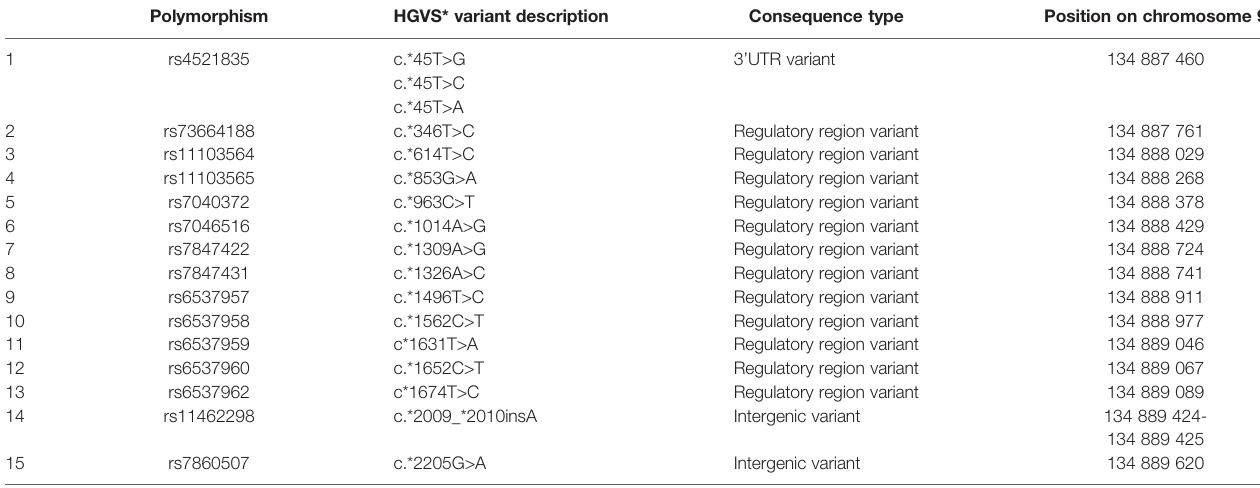
TABLE 3 | Polymorphisms identi fi ed in the FCN2 gene 3 ’ UTR region. Polymorphism